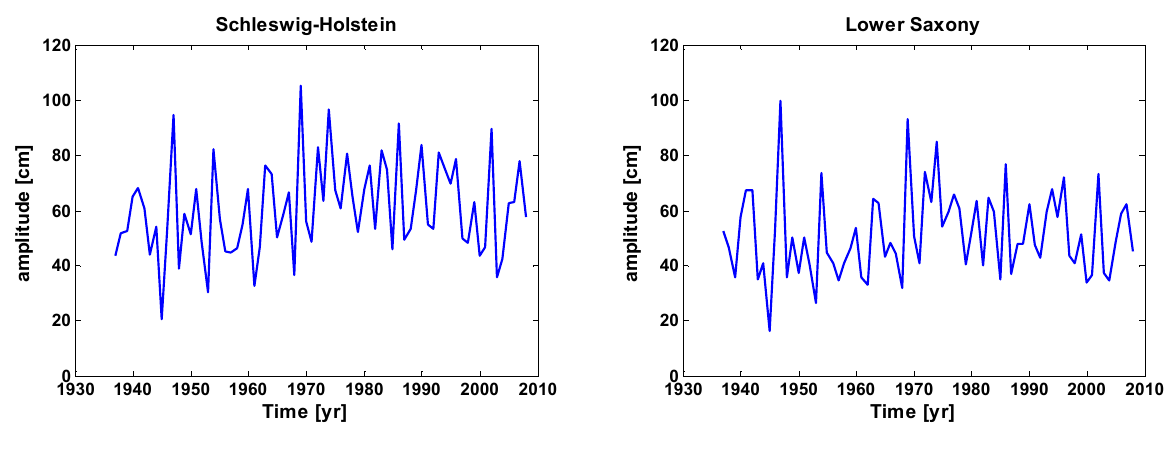
Figure 4. Time series of annual amplitude for the virtual stations of Schleswig-Holstein and Lower Saxony for the period from 1937 to 2008. The annual amplitudes are computed as differences of monthly maximum and minimum values for each